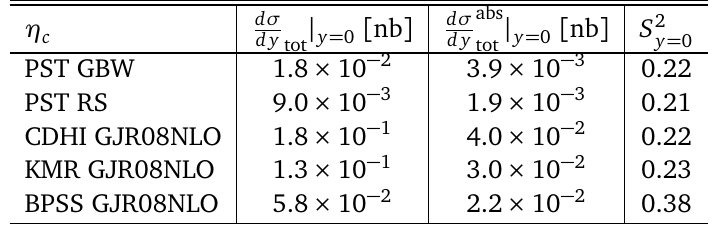
CEP for various prescriptions and UGD c